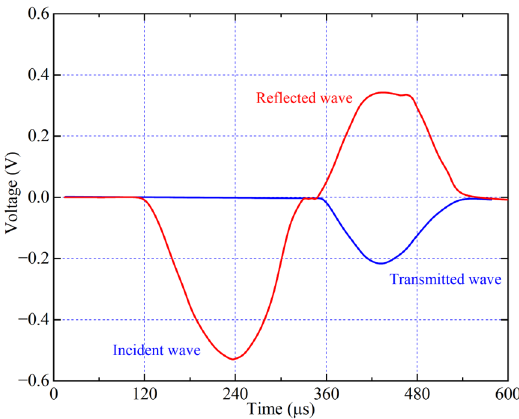
Figure 5. Typical strain gauge signals.